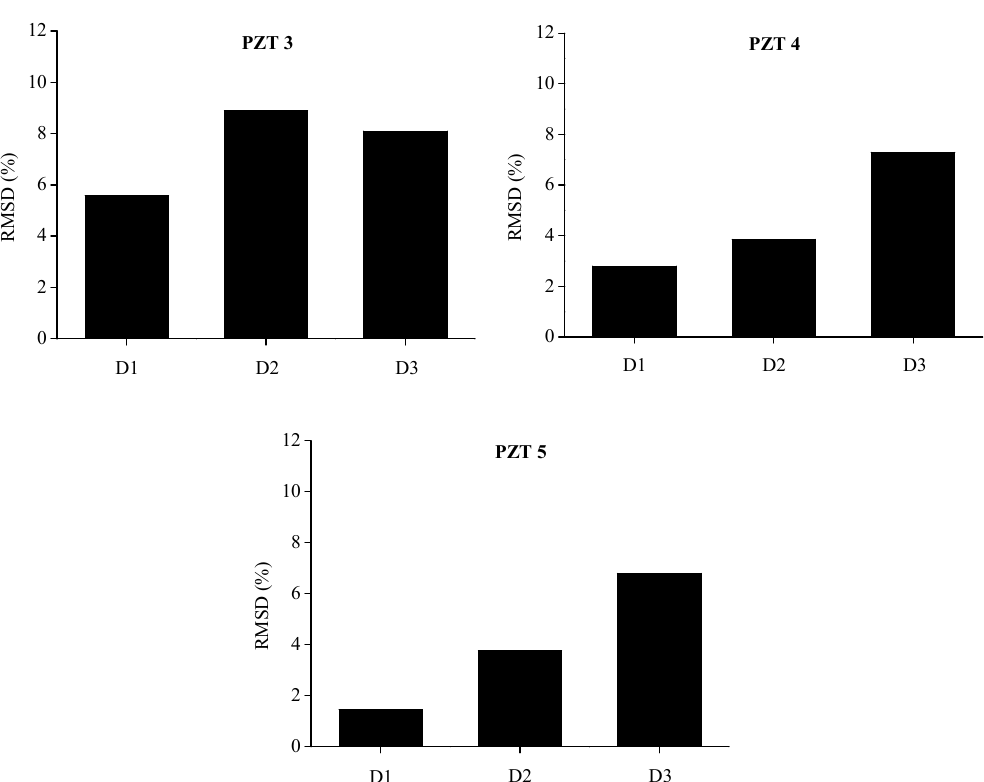
ff erent damage levels. Figure 11. Experimental RMSD values of each PZT sensor for BE1 under different damage levels.